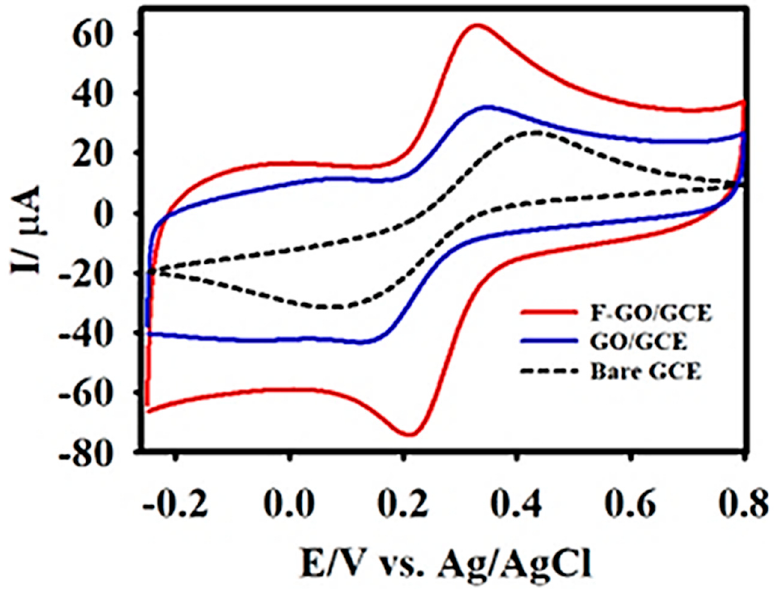
Figure 3. The cyclic voltammetry (CV) curves of the bare glassy carbon electrode (GCE) (black dashed line), GO/GCE (blue line), and F-GO/GCE (red line) recorded in 0.1 M KCl containing 5.0 mM [Fe(CN) 6 ] 3 − /4 − at the scan rate of 50 mV s − 1 .